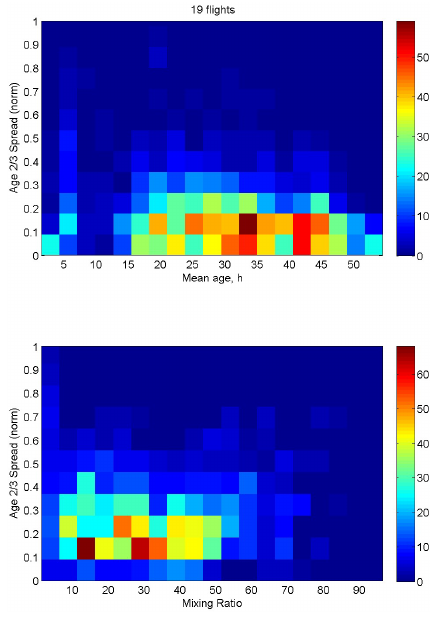
Figure 11: Frequency of occurrence of CO tracer spread along the P3 flight tracks vs. simulated 568 Figure 11. Frequency of occurrence of CO tracer spread along the mean tracer age (top) and simulated mixing ratio (bottom) for all points with valid CO 569 P3 flight tracks vs. simulated mean tracer age (top) and simulated measurements below 1000 m AGL.570 mixing ratio (bottom) for all points with valid CO measurements below 1000ma.g.l.